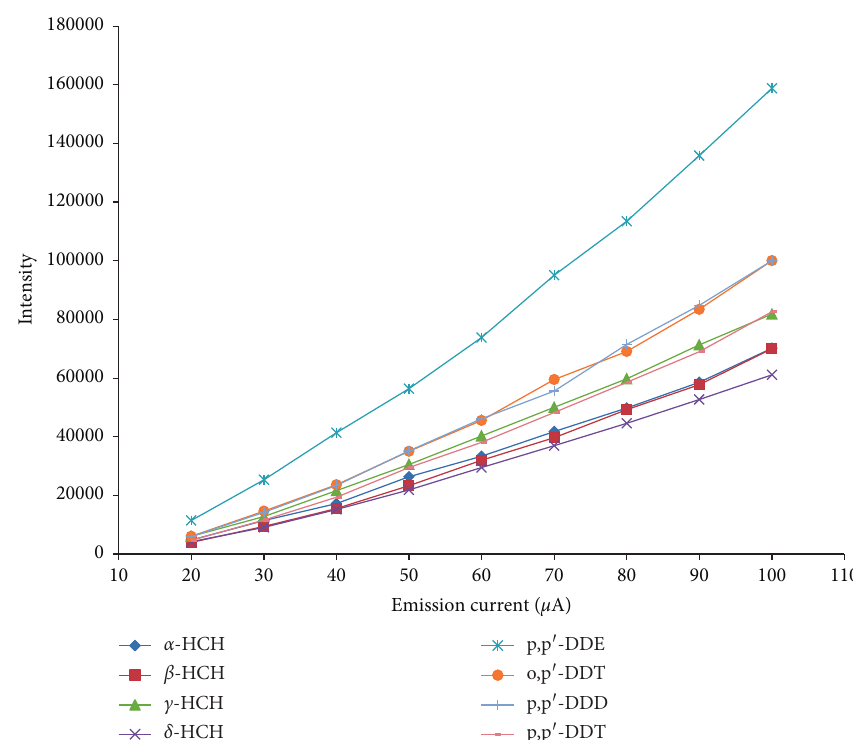
Figure 4: Absolute intensity of chloride ionized at different emission current values for eight organochlorine pesticides: α -hexa- chlorocyclohexane ( α -HCH), β -hexachlorocyclohexane ( β -HCH), c -hexachlorocyclohexane ( c -HCH), δ -hexachlorocyclohexane ( δ -HCH), 1-chloro-2-[2, 2, 2-trichloro-1-(4-chlorophenyl) ethyl] benzol (o, p ′ -DDT), 2, 2-bis ( p -chlorophenyl)-1, 1, 1-trichloroethane ( p , p ′ -DDT), 2, 2-dichloro-1, 1-bis (4-chlorophenyl) ethylene ( p , p ′ -DDE), and 1, 1-dichloro-2, 2-bis ( p -chlorophenyl) ethane ( p , p ′